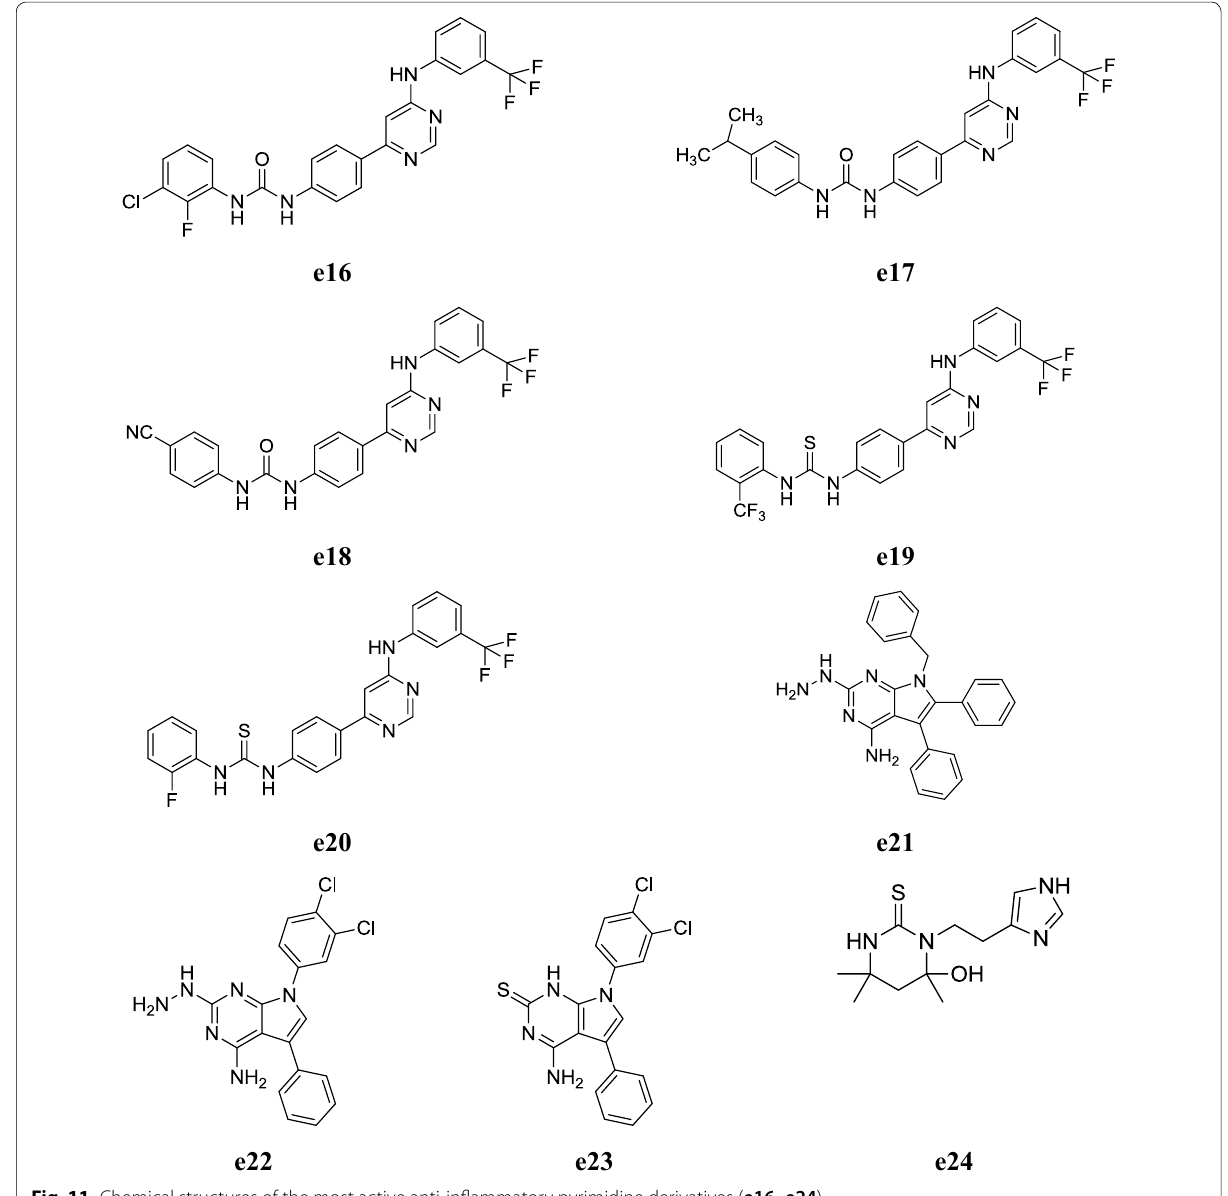
Fig. 11 Chemical structures of the most active anti-inflammatory pyrimidine derivatives ( e16 – e24 )